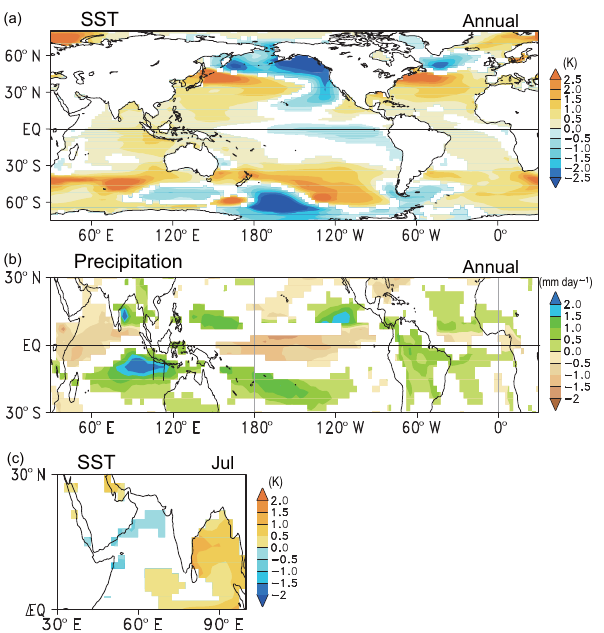
Figure 13. (a) Differences in the annual mean SST between strong and weak stratospheric westerly jet experiments, similar to Fig. 11. (b) Same as (a) , except for the annual mean precipitation. (c) Same as (a) , except for July mean SST in the Indian Ocean sector. Units are (a) K, (b) mmday − 1 and (c) K. Colour shading indicates re- gions where statistical significance exceeds the 95% level.